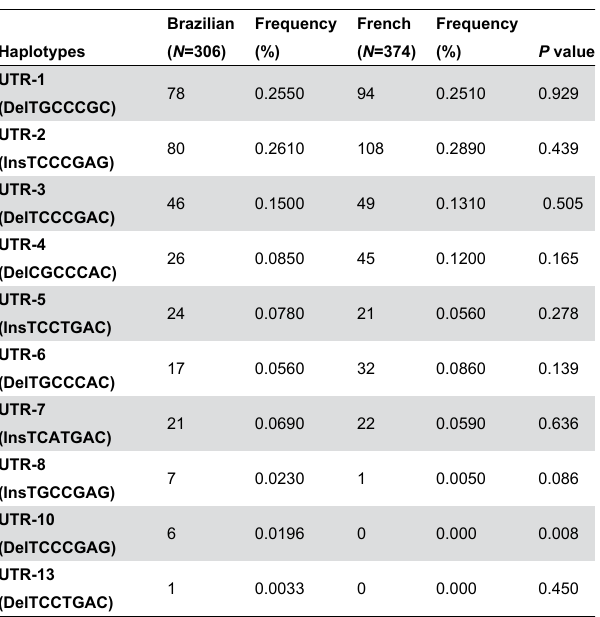
Table 2. Haplotype frequencies observed at the HLA-G 3’UTR polymorphic sites (14bp Ins/Del, 3003C/T, 3010C/G, 3027A/C, 3035C/T, 3142C/G, 3187A/G, 3196C/G) in Brazilian and French